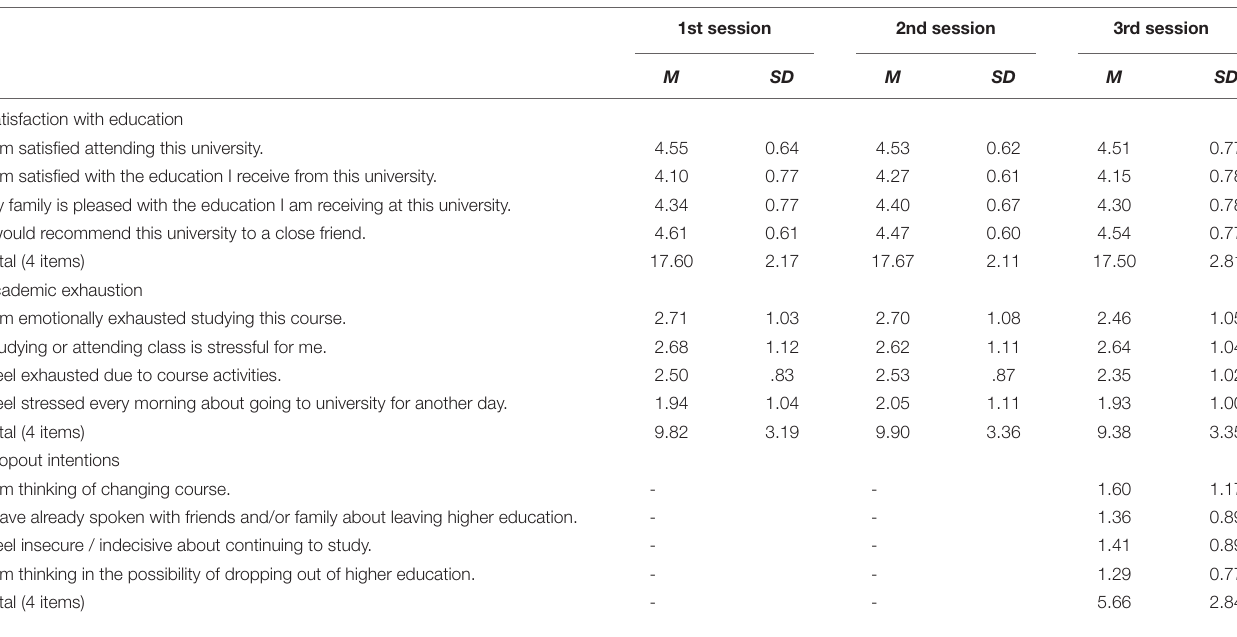
TABLE 3 | Results of the dropout risk screening